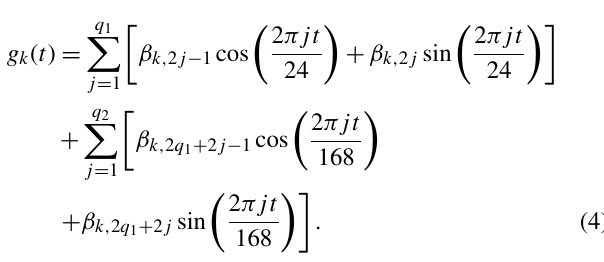
Figure 3. Evolution of the BIC criteria according to the number of